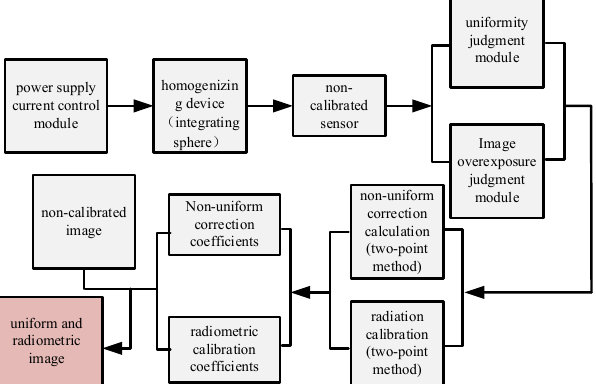
Figure 2. Radiation calibration data processing flow